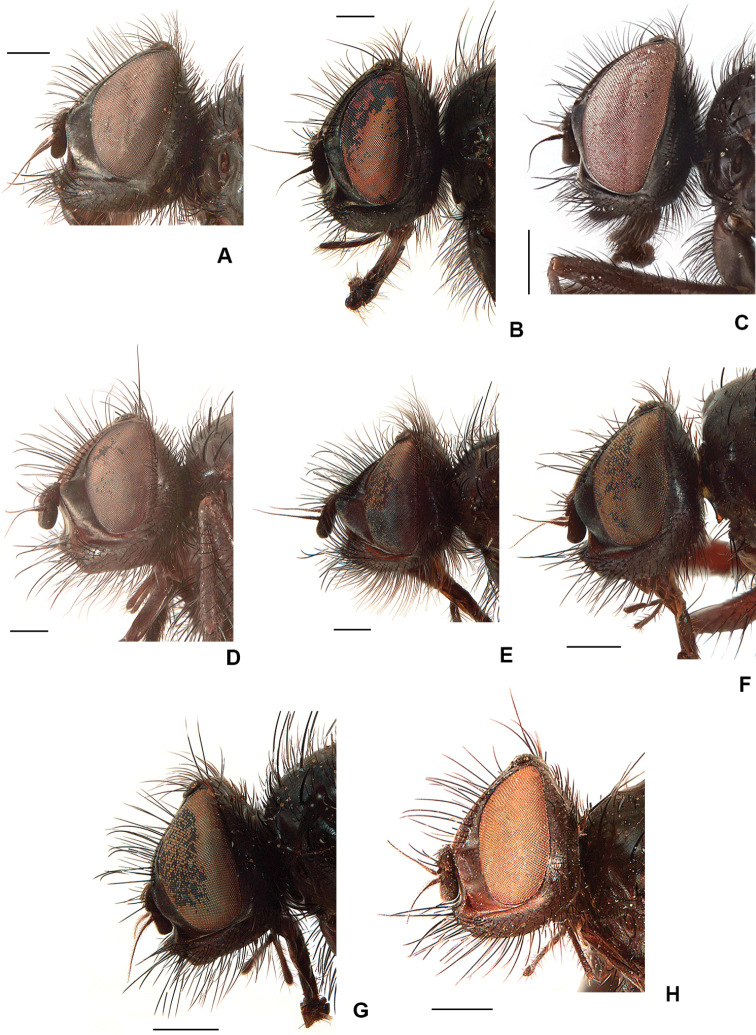
Male head, lateral view AD.
pribilofensisBD.
neoborealisCD.
vockerothiDD.
spinitarsisED.
glacialisFD.
santamonicaeGD.
amnicolaHD.
minor. Scale bars: 0.5 mm.